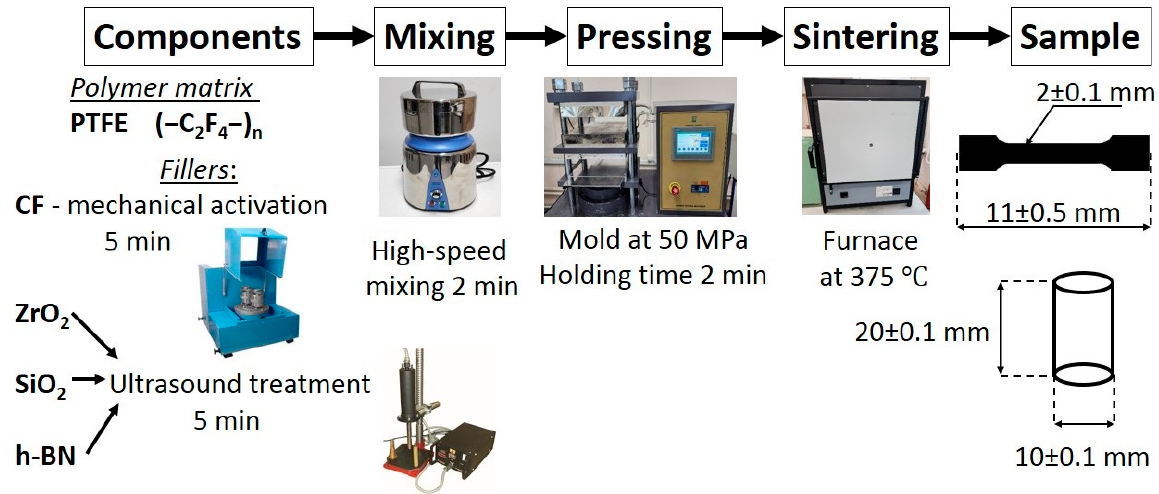
Figure 1. Sample preparation schematically.